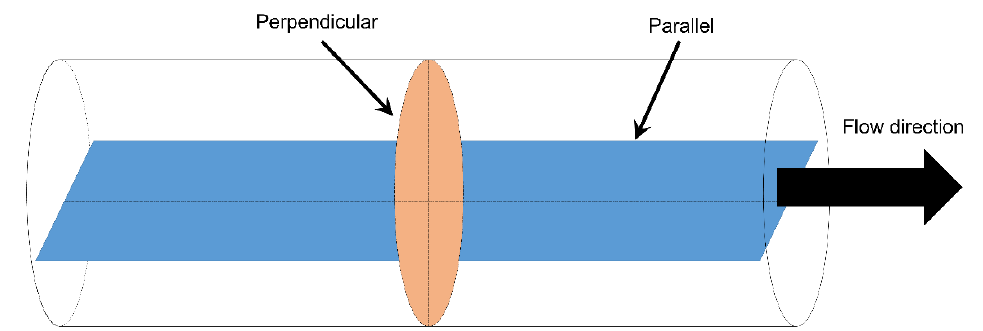
Figure 3. Schematic of the perpendicular and parallel section in a filament for transmission electron microscopy (TEM) observation.